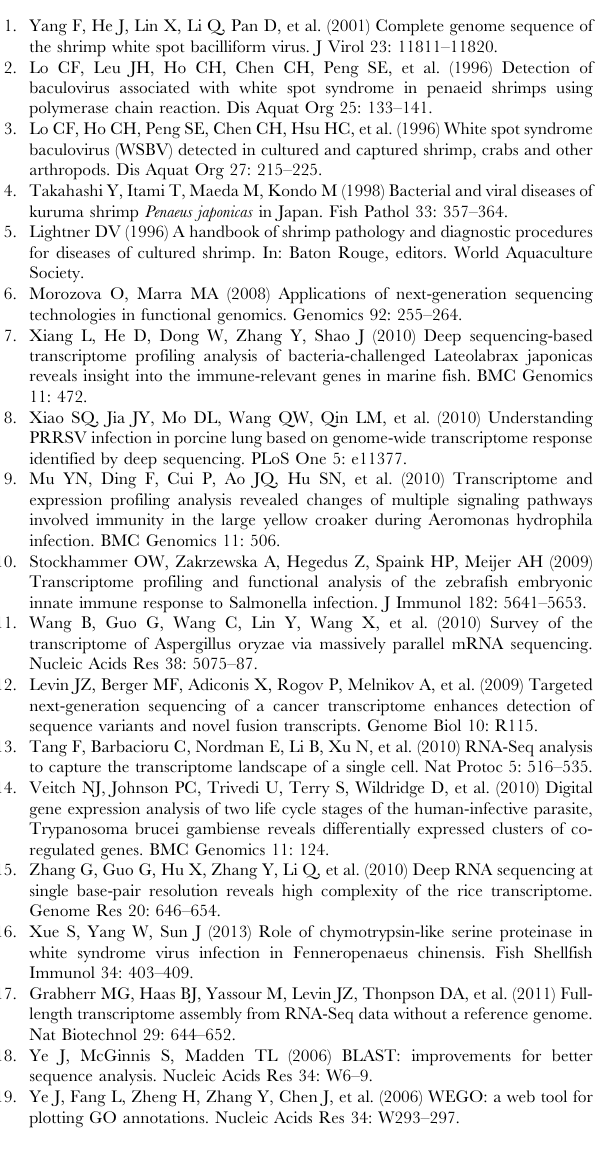
Table S1 Details on immune-related genes/homologues in L. Table S2 Differentially expressed genes between the mock and early infection samples. Table S3 Differentially expressed genes between the mock and late infection samples.